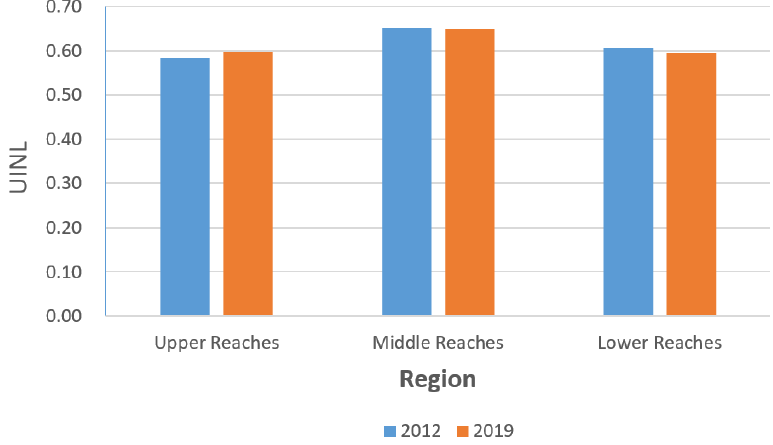
Figure 14. The UINL for three reaches in YREB.